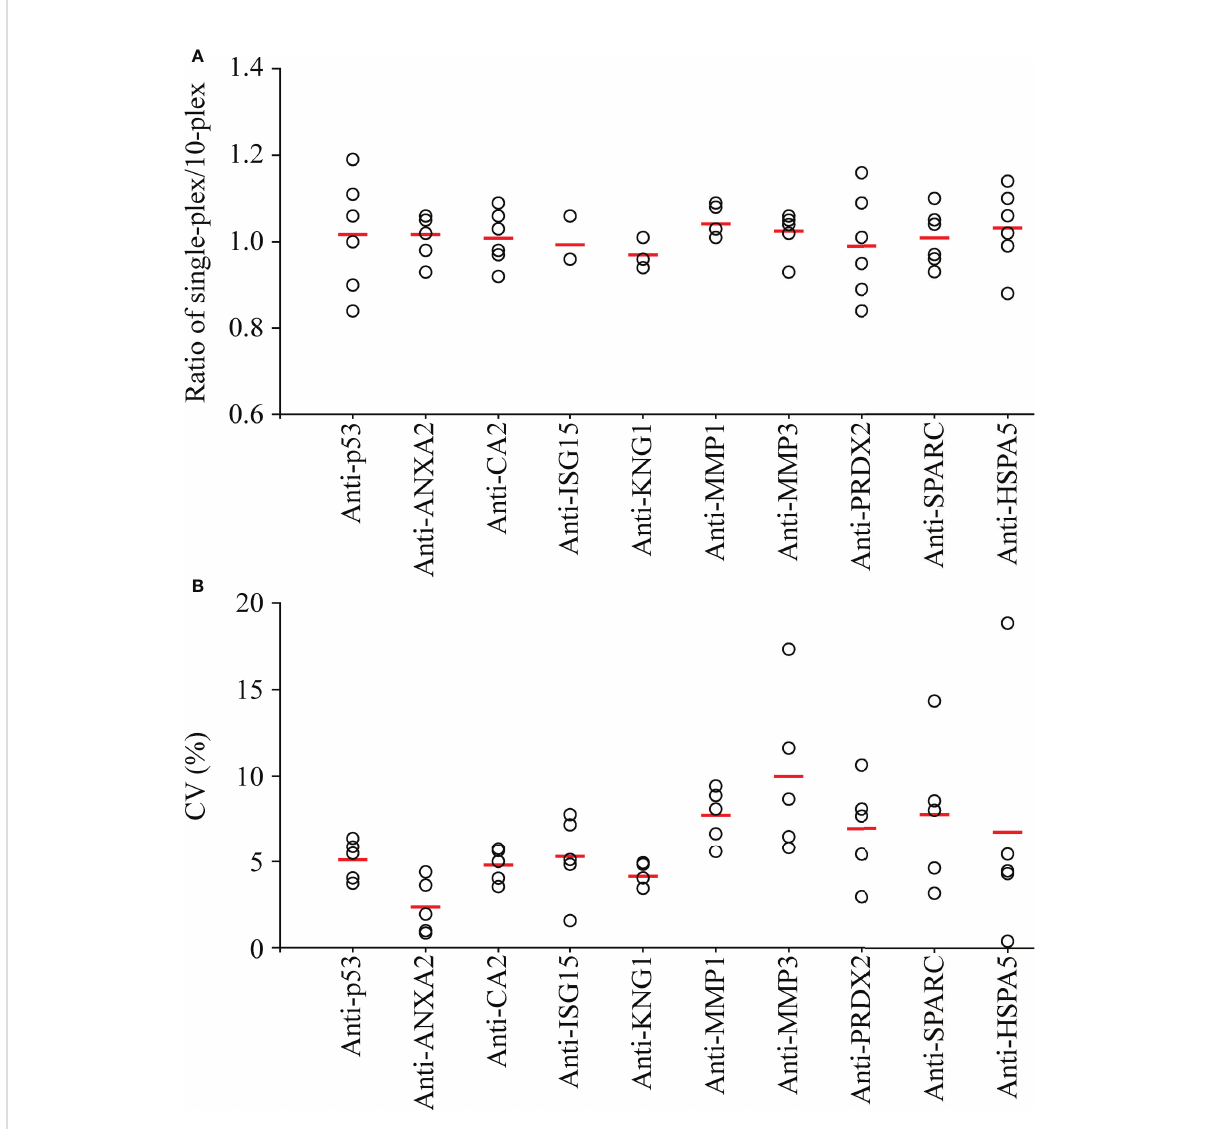
FIGURE 3 Assessment of the cross-reactivity and inter-assay precision of the multiplexed auto-Ab immunoassay. (A) To evaluate the cross-reactivity of the multiplexed immunoassay, six pooled salivary samples, each of which was pooled from saliva samples of six OSCC patients and six healthy controls, were subjected to detection of the 10 auto-Abs using individual protein-conjugated beads (single-plex) and using equally mixed beads respectively for 10 auto-Abs (10-plex) in parallel. Results are presented as a ratio of the auto-Ab level acquired in single-plex to that in 10-plex for each of the six pooled samples (open circles), and the mean auto-Ab ratio of the six pooled samples is indicated with a red thick line. (B) To investigate the inter-assay precision of the 10-plex immunoassay, measures of auto-Ab levels in fi ve pooled saliva samples were taken at three different time points. Results are presented as the coef fi cient of variation (CV) of auto-Ab levels acquired from the three batches of individual pooled samples (open circles), and the mean CV of the auto-Ab in the fi ve samples is indicated with a red thick